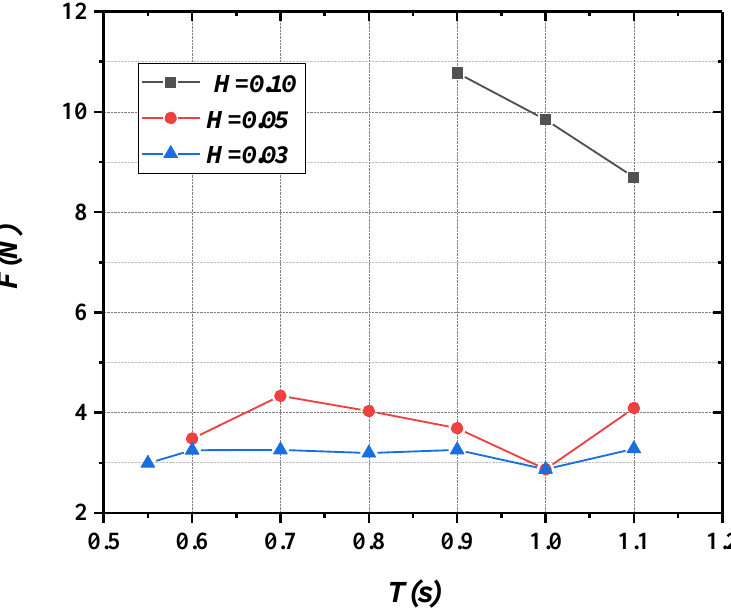
Figure 32. Variations of 3# mooring force.